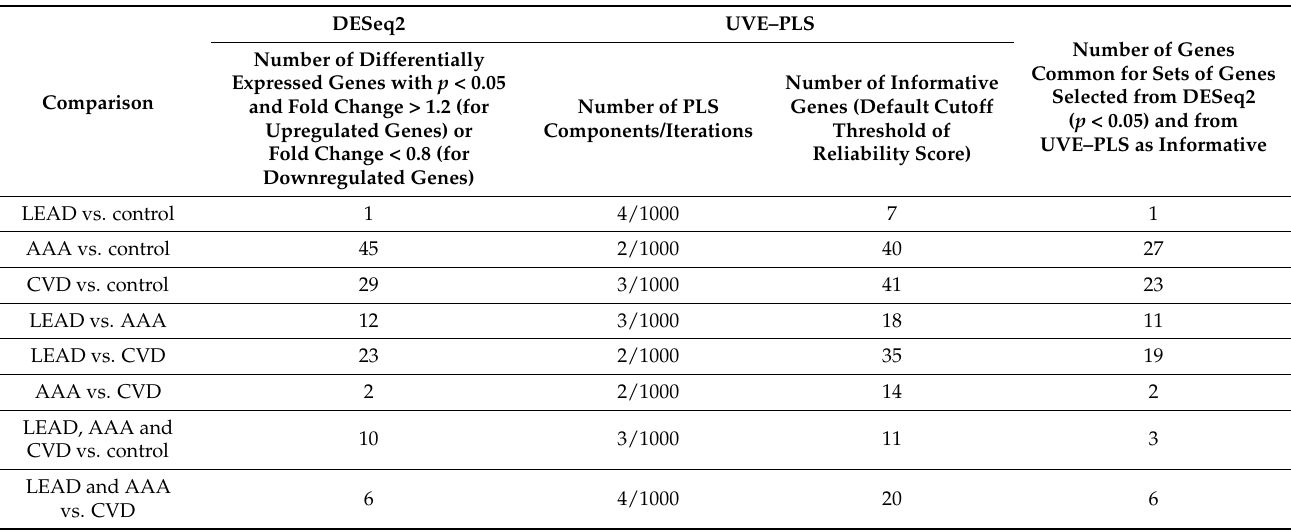
Table A1. General results of differential gene expression analysis performed using DESeq2 and UVE-PLS methods obtained for